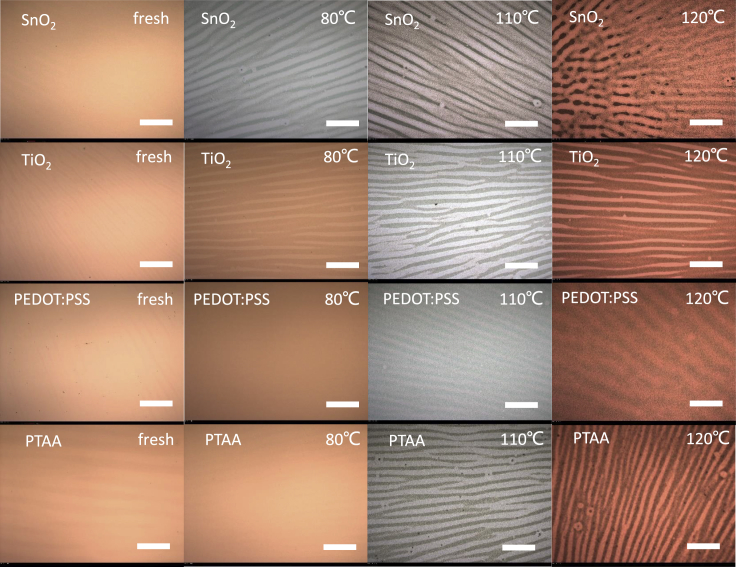
Optical Microscope Images of Perovskite FilmsOptical microscope images of perovskite films deposited on different interfacial layers under thermal aging with different temperatures. Scale bars in all pictures represent 200 μm.